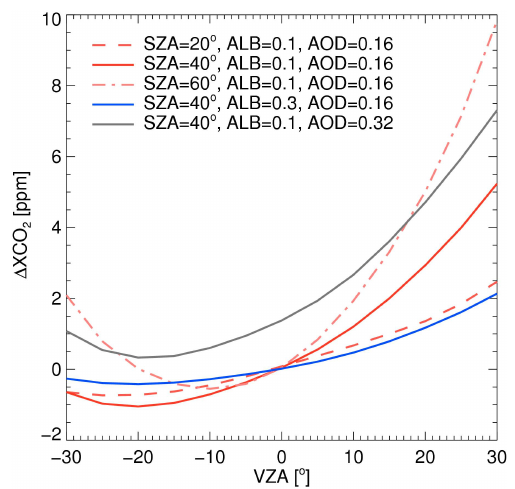
Fig. 6. Simulated systematic WFM-DOAS XCO 2 errors ( 1 XCO 2 ) for different viewing zenith angles (VZA). The simulations are for scenarios with different solar zenith angles (SZA), surface albedos (ALB) and aerosol optical depths (AOD) at